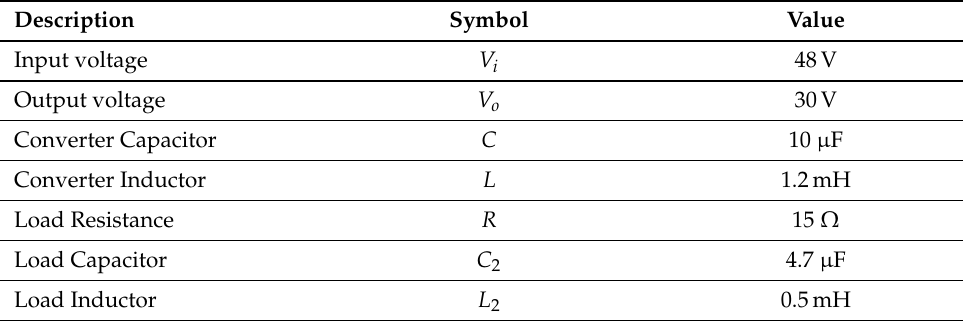
Table 1. The Buck converter parameters.